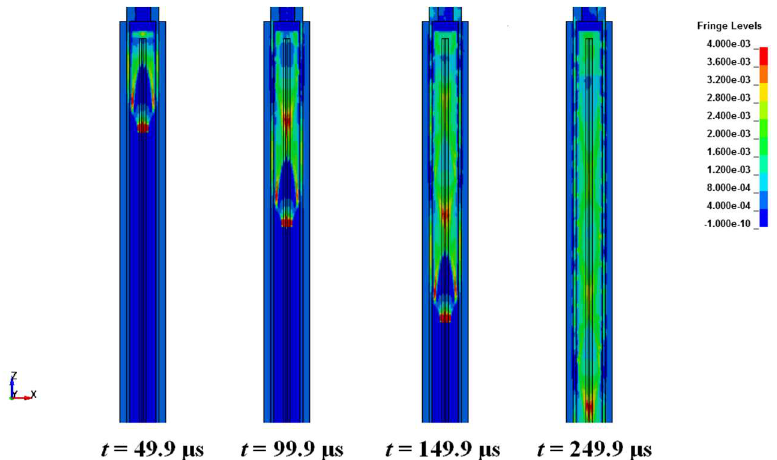
Figure 6. Pressure variation of perforation gun section (units for contour plots: 10 11 Pa).